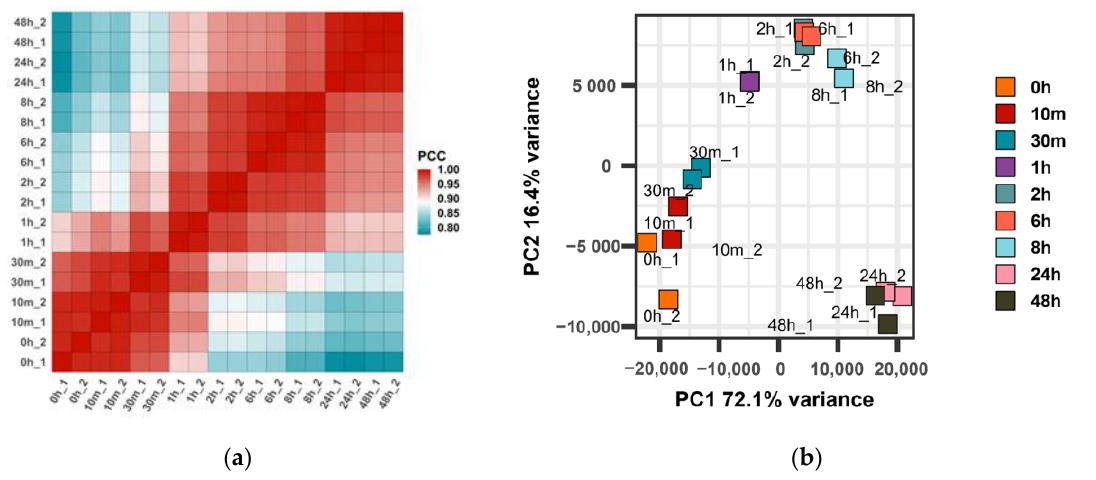
Figure 1. Evaluation of transcriptome dataset used to identify alternative splicing (AS) events. ( a ) Gene Expression Correlation analysis of transcriptome samples. PCC: Pearson correlation coeffi- cient. ( b ) Principal component analysis of transcriptome samples. PC1: Principal Component 1. PC2: Principal Component 2.